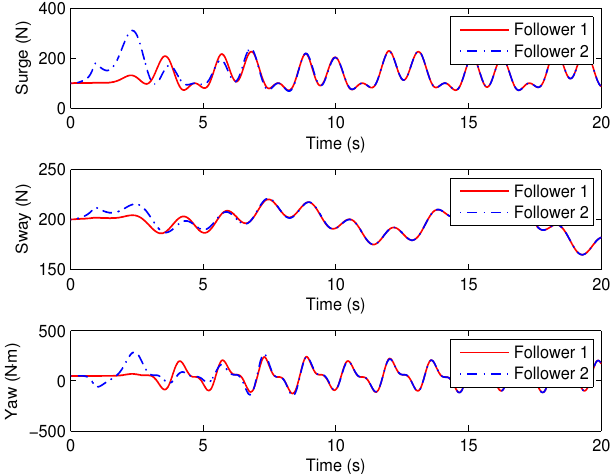
Figure 4. Model uncertainties and